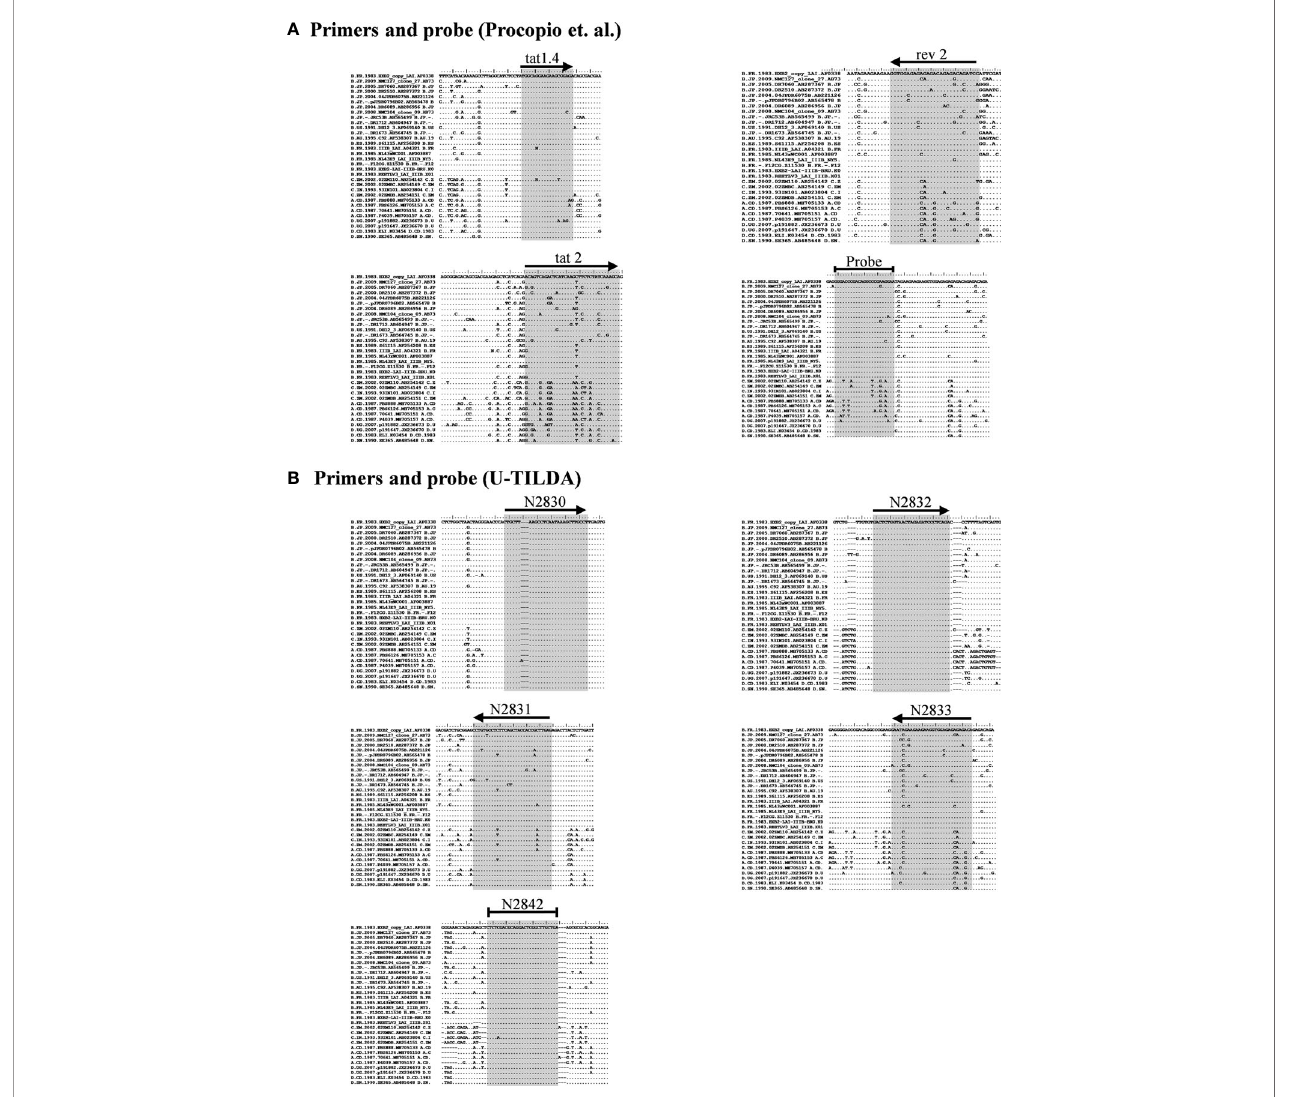
FIGURE 2 | Multiple sequence alignment of representative viral strains. (A) The primers and probe of Procopio et al. (B) The primers and probe of the U-TILDA. The regions targeted by the primers and probes of several strains belonging to the major HIV-1 subtypes were downloaded from the Los Alamos HIV Sequence Database. The alignment of a few representative sequences of each subtype is presented here. The target sequences are highlighted by shading. The horizontal arrows represent the orientation of the primers. A blunted horizontal line represents probes. Dots represent sequence identity and dashes deletions. The labels of the oligos represent their